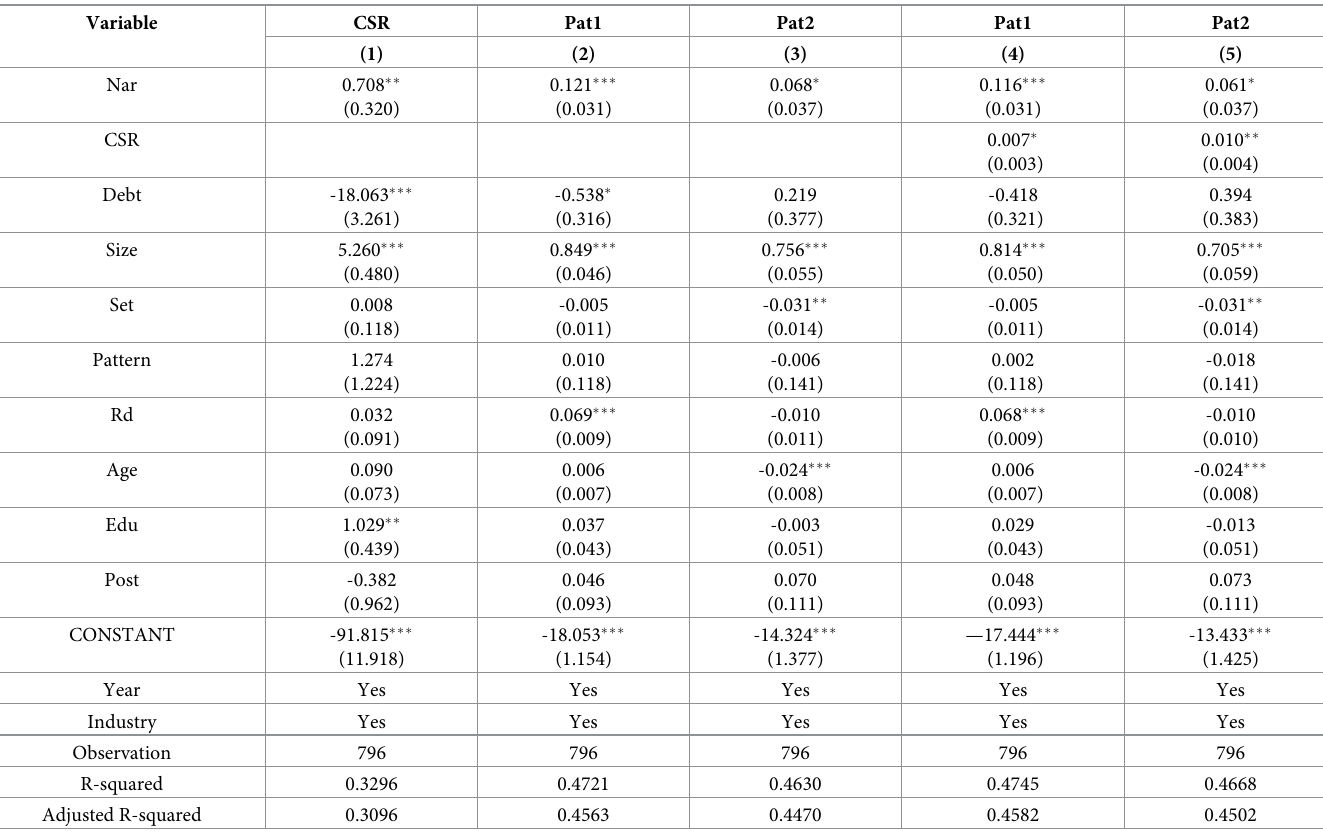
Table 8. Principal component factor analysis—robustness test of mediation